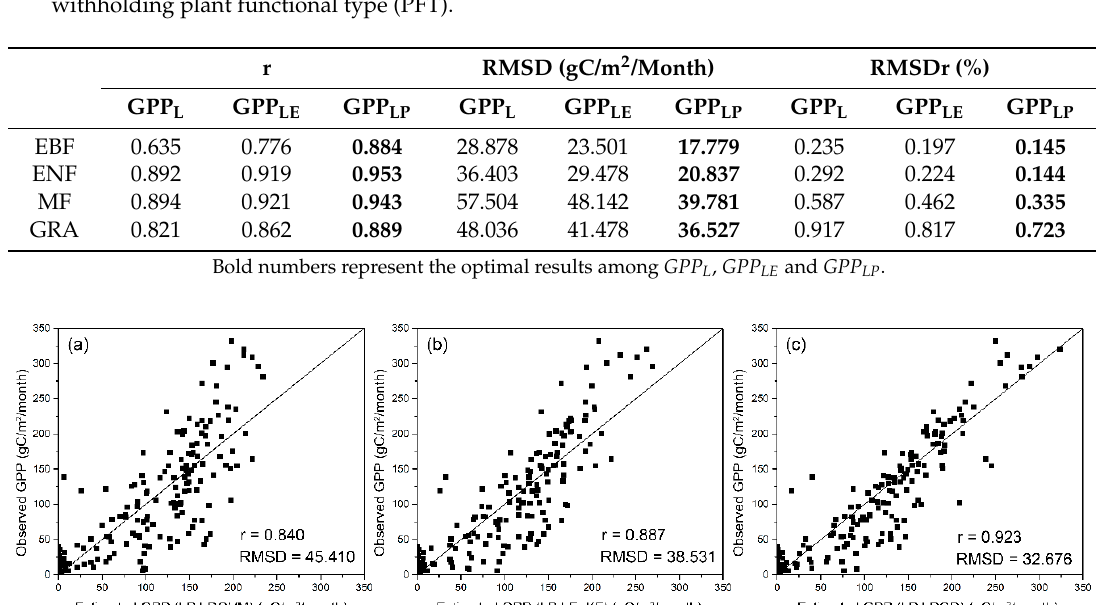
Figure 7. Spatial distributions of ( a ) annual averaged gross primary productivity (GPP); and ( b ) standard deviation ( SD ) of GPP during 2003–2012 in